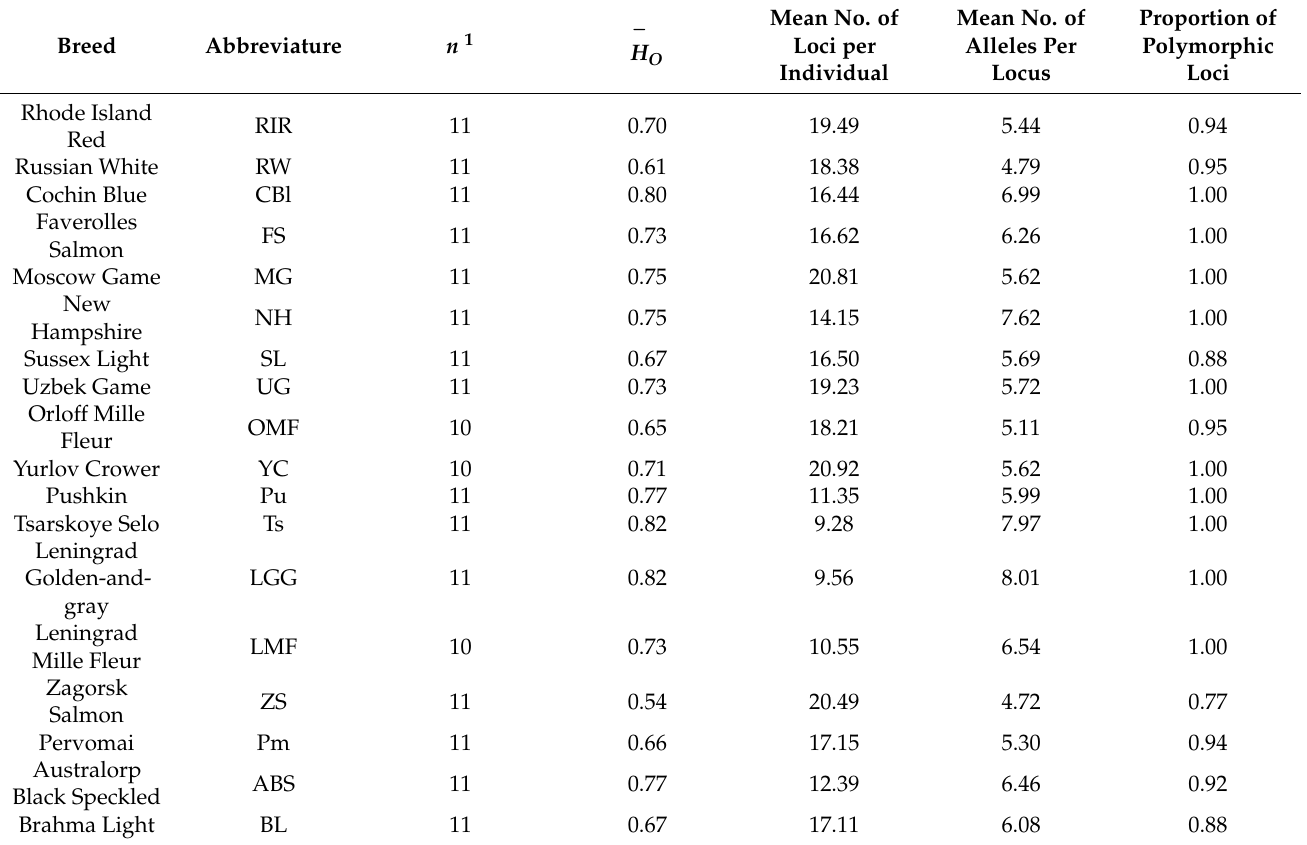
¯ H O ) and other genetic diversity indicators computed using the Table 1. Mean heterozygosity ( GELSTATS™ program in 18 chicken breeds analysis of fingerprinting